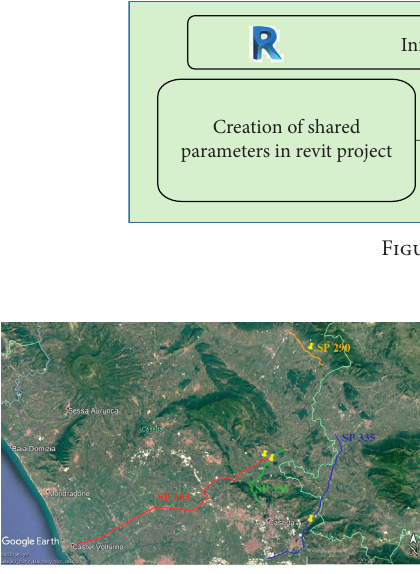
Figure 2: Aerial view of the study area that contains the analyzed road